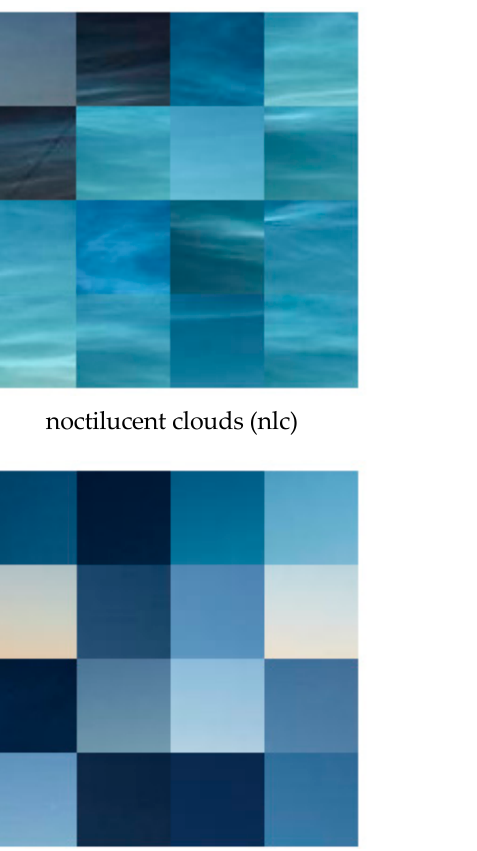
Figure 4. Resized image divided into blocks of size N-by-N pixels. First, an input image (typically of size 3456 by 2304 pixels) is resized to one-quarter of the original size. Downsampling an image helps to reduce the computational complexity of analysis. Second, as NLC activity is spatially localized in a given image, the resized image is divided into image blocks of size N-by-N pixels each as shown in Figure 4, for our experiments we used N = 50